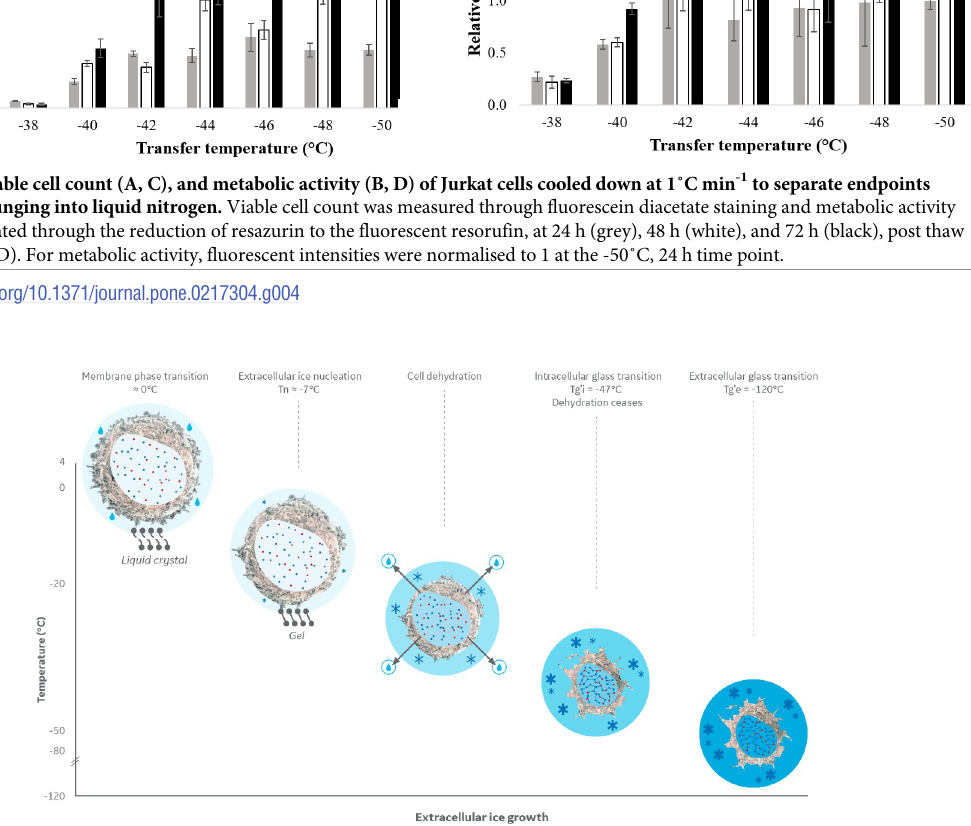
Fig 5. Schematic of the physical transitions occurring during cryopreservation of a Jurkat cell in the presence of dimethyl sulfoxide. As temperature decreases (from left to right), the cell membrane first undergoes a liquid-crystal to gel phase transition, with its midpoint at approximately 0˚C. At approximately -7˚C ice starts to nucleate in the extracellular compartment and with ice crystal growth the extracellular solute concentration increases. Intracellular water flows out of the cells in response to the osmotic gradient. As cell dehydration takes place, the intracellular compartment becomes more and more crowded (the blue and red dots symbolising various macromolecules), until it undergoes a glass transition, starting at -47˚C. Intracellular macromolecules now form a network (linked dots) analogous to a colloidal glass, that behaves as a molecular sieve in which nanopores still remain liquid. Upon further cooling, the extracellular compartment and the intracellular nanopores undergo a glass transition at -123˚C (darkening of the blue shade of the intra- and extracellular compartments). Below this temperature, molecular mobility ceases. Jurkat cell images adapted from Walter et al. [24].